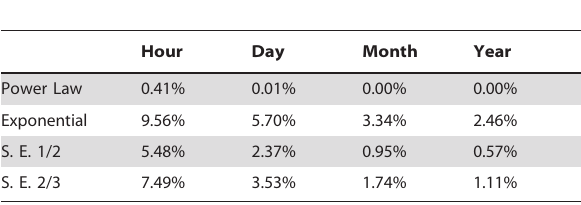
Table 2. Estimated Fraction of Protein Domains with Folding Times Greater than Time Indicated.